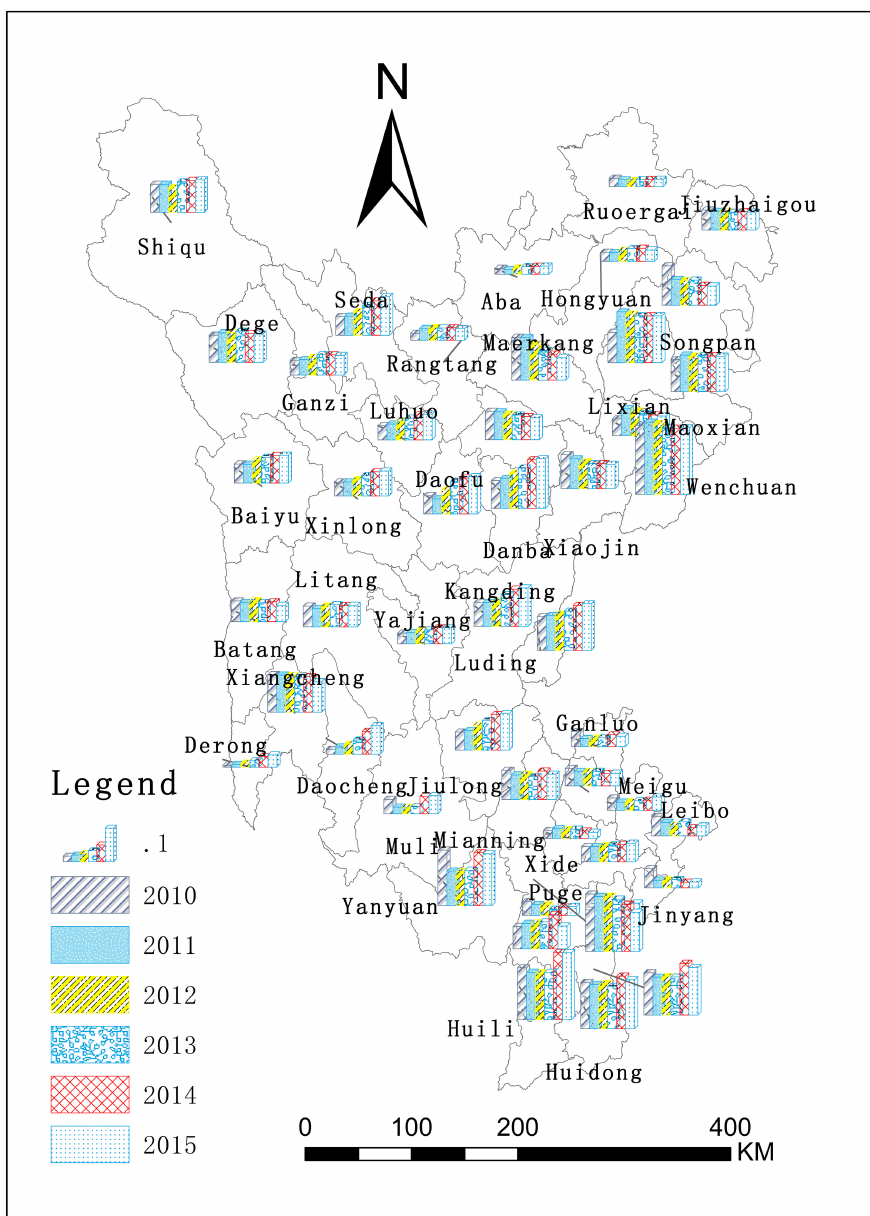
Figure 5. Physical capital